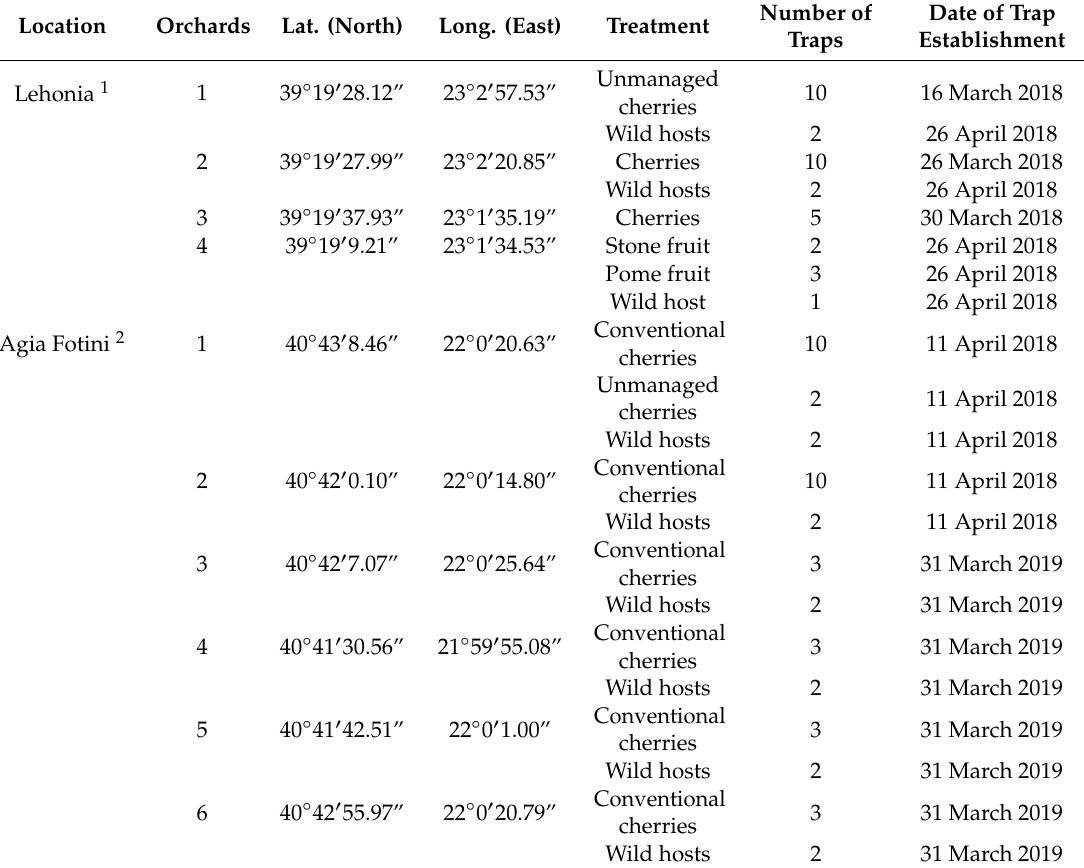
Number of Date of Trap Traps Establishment